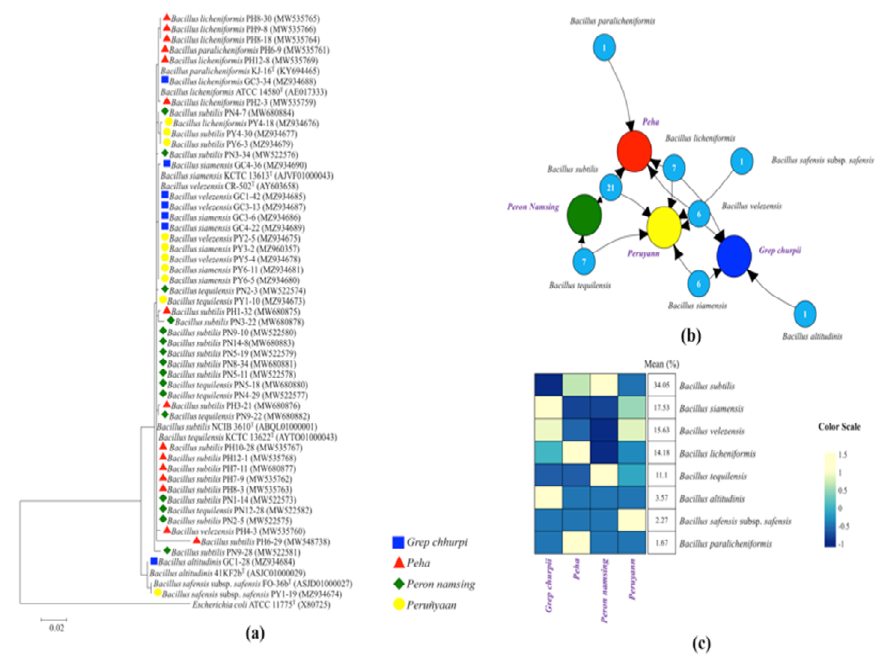
Figure 4. ( a ) Evolutionary relationships of taxa from grep chhurpi , paeha/peha , peron namsing , and peruñyaan; the evolutionary history was inferred using the maximum-likelihood method. ( b ) Graphical network representation of the shared and unique diverse Bacillus species isolated from different fermented soybean products of Arunachal Pradesh, India: grep chhurpi, peha/paeha, peron namsing, and peruñyaan . The numbers in the circles indicate the number of each species identified by 16S rRNA gene sequencing. ( c ) Distribution (%) of Bacillus spp., in each product.